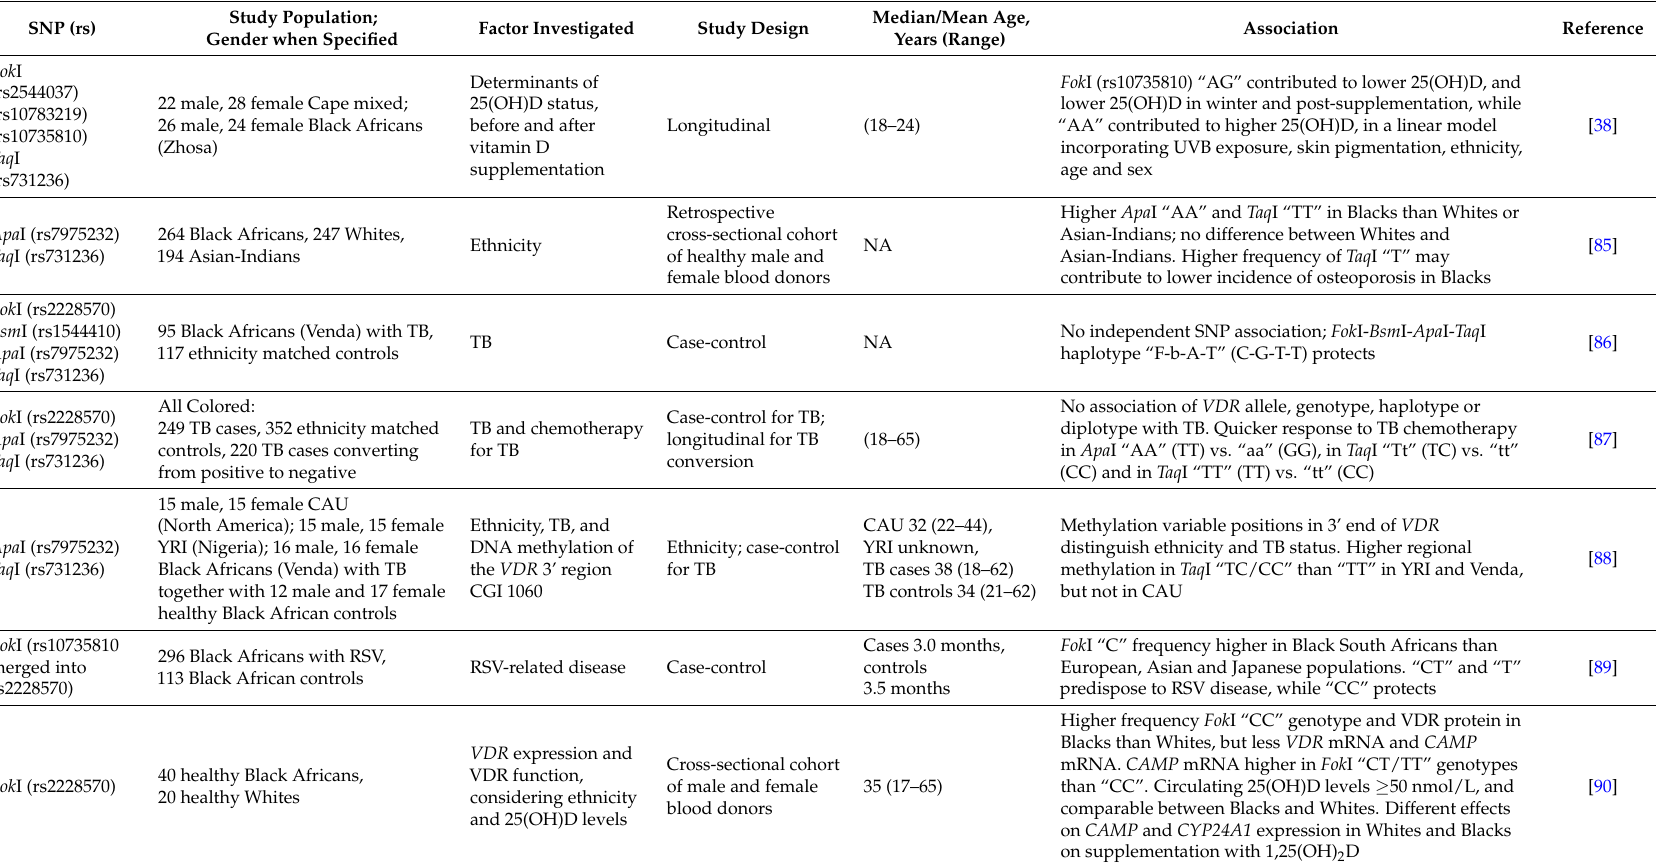
Table 4. Vitamin D receptor gene ( VDR ) variants in South Africans, associated with ethnicity, disease, treatment response, DNA methylation, VDR expression, vitamin D receptor protein (VDR) level or VDR transactivation of target